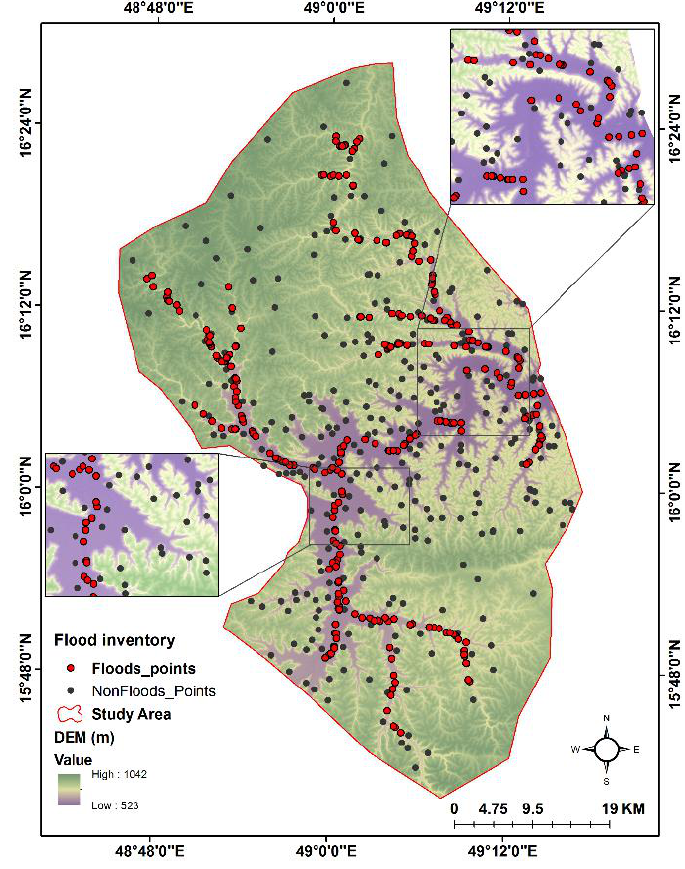
Figure 6. Flood inventory map of the study area.